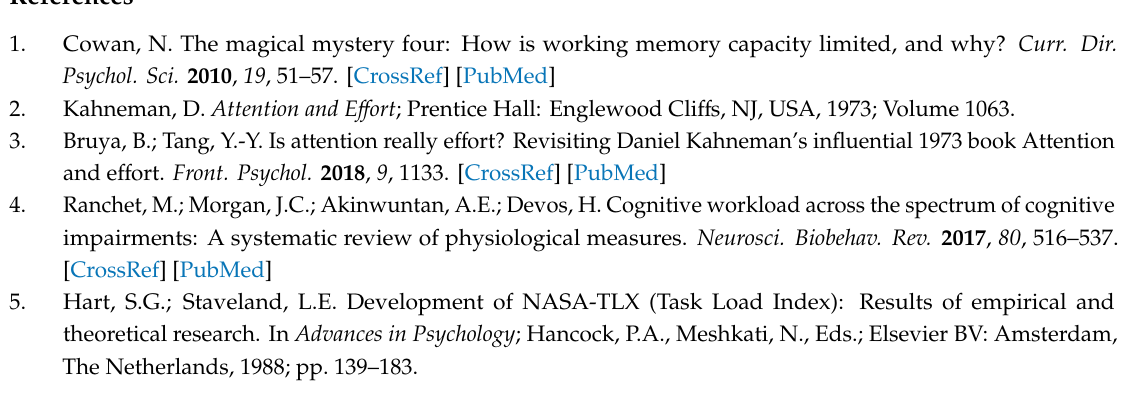
Table S1: IntraClass Correlation Coe ffi cients (ICC) of NASA-TLX and ICA of the Three